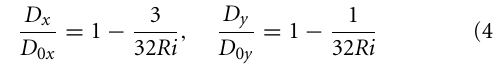
FIGURE 4 | Normalized x (left) and y (right) components of the drag as a function of Ri for the wind profile (45). The solid and dash-dotted lines correspond to non-Boussinesq calculations (with different signs of α –